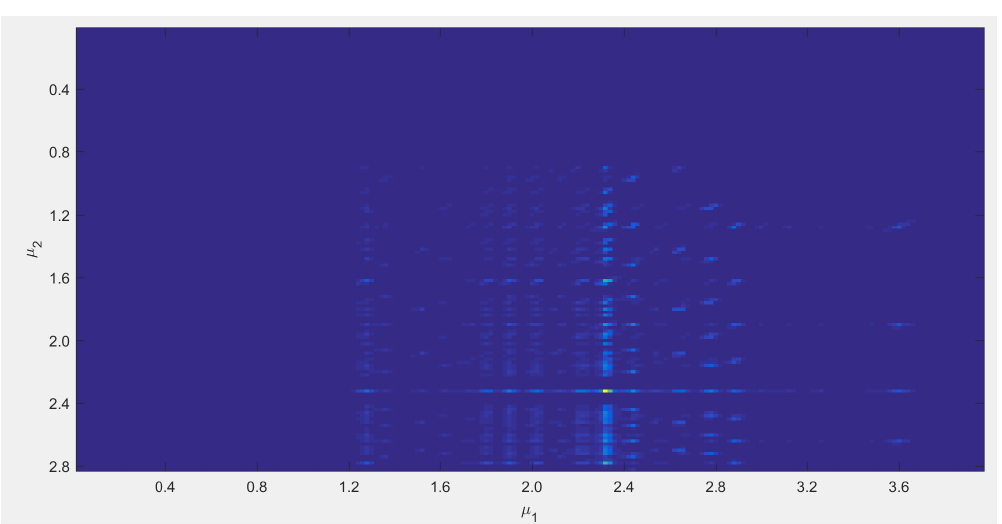
Figure 5. An example of the activation co-occurrence histogram. The axes represent the relative scale and locations of activations of a pair of parts.